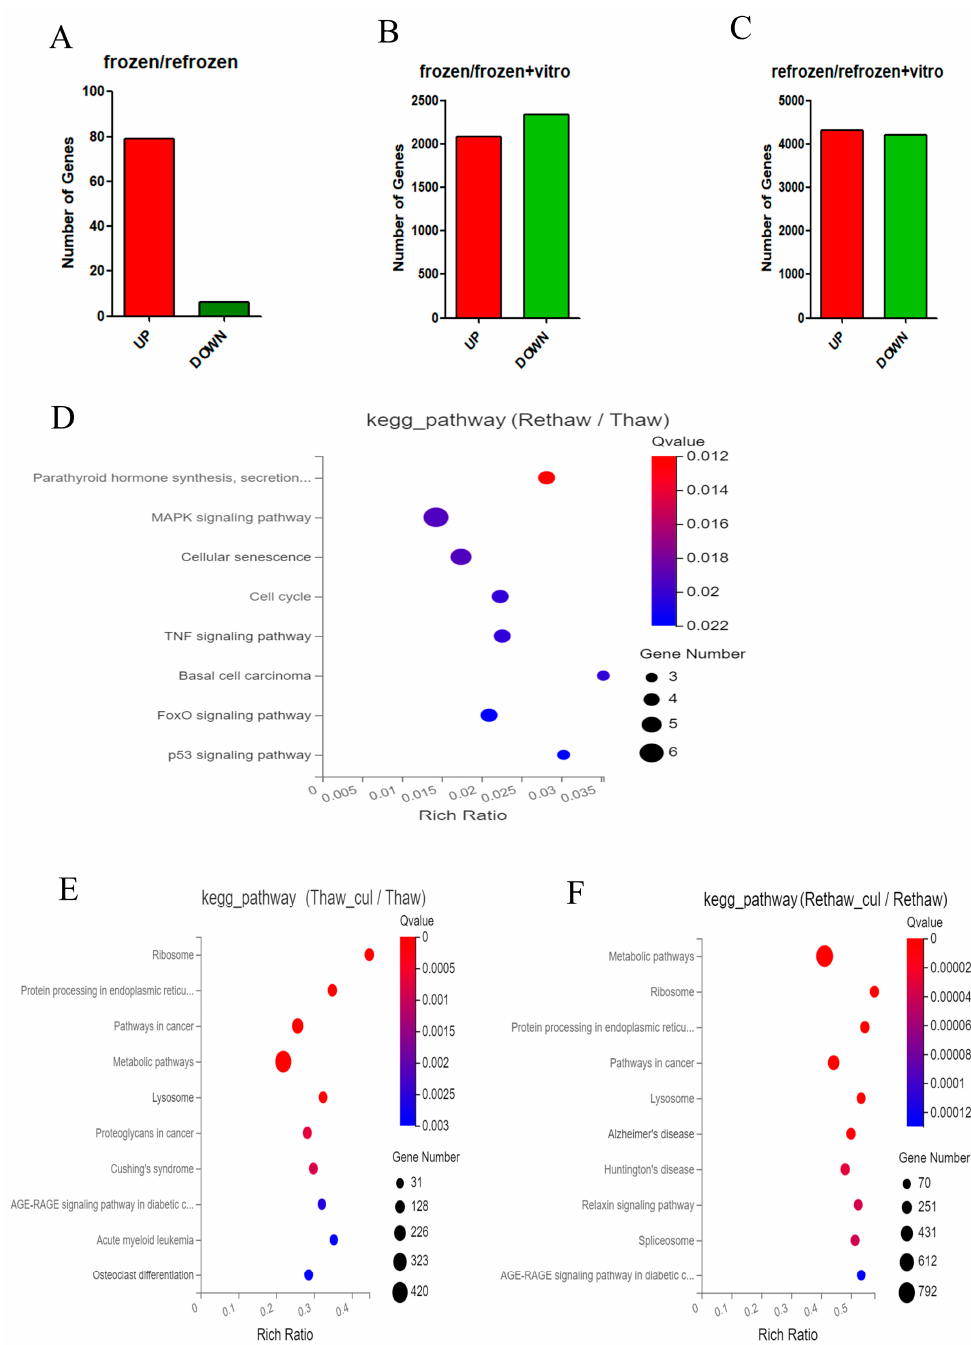
Figure 1. Visualization of Kyoto Encyclopedia of Genes and Genomes (KEGG) pathway enrichment for differential expression genes in cryopreserved ovarian cells in different comparisons. ( A ) Number of genes up- and downregulated in cells of Group 1 (one-time cryopreservation) and in cells of Group 2 (two-time cryopreservation). ( B ) Number of genes up- and downregulated in cells of Group 1 (one-time cryopreservation) and in cells of Group 3 (one-time cryopreservation and in vitro culture). ( C ) Number of genes up- and downregulated in cells of Group 2 (two-time cryopreservation) and in cells of Group 4 (two-time cryopreservation and in vitro culture). ( D ) Significant gene KEGG pathway in cells of Group 1 (one-time cryopreservation) and in cells of Group 2 (two-time cryopreservation). ( E ) Significant gene KEGG pathway in cells of Group 3 (one-time cryopreservation and in vitro culture). ( F ) Significant gene KEGG pathway in cells of Group 2 (two-time cryopreservation) and in cells of Group 4 (two-time cryopreservation and in vitro culture).